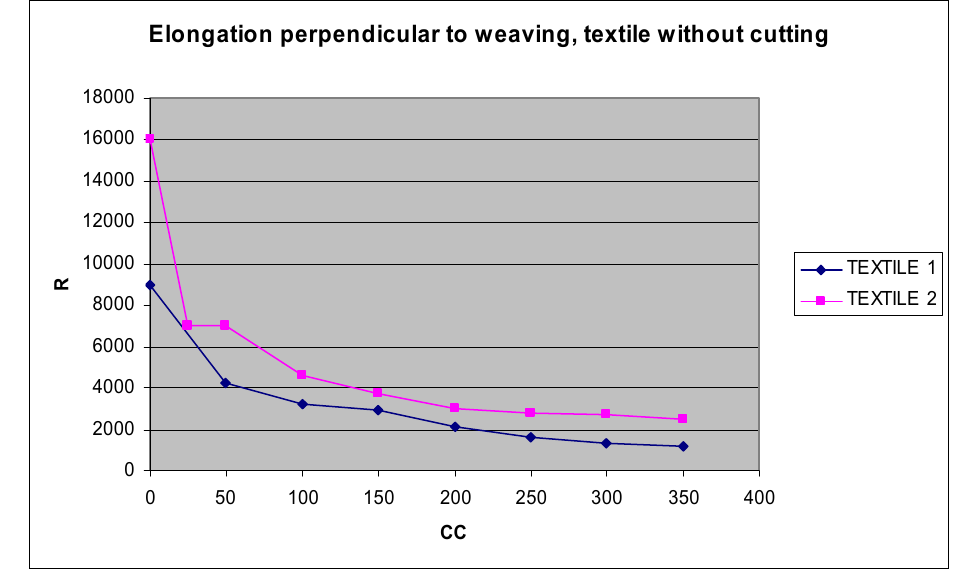
Figure 6. Graphic of the third test presented.